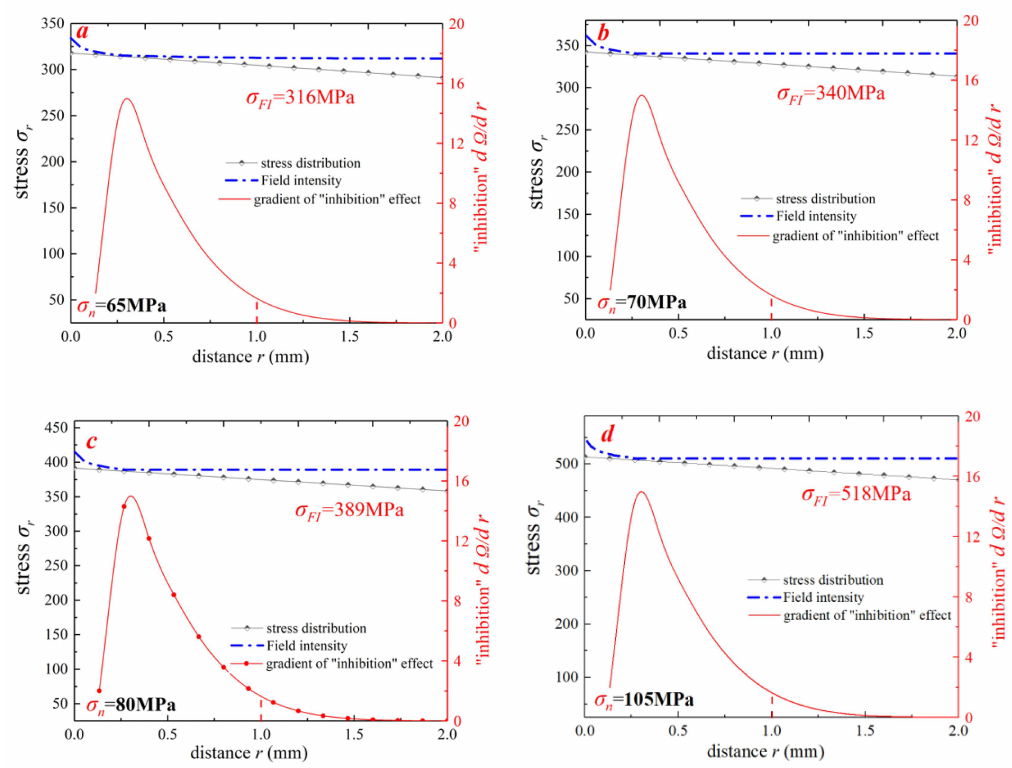
Figure 17. Simplified novel SFI method to analyze the stress field near the concentration point of the intersecting line under the four load conditions: ( a ) 65 MPa, ( b ) 70 MPa, ( c ) 80 MPa, and ( d ) 105